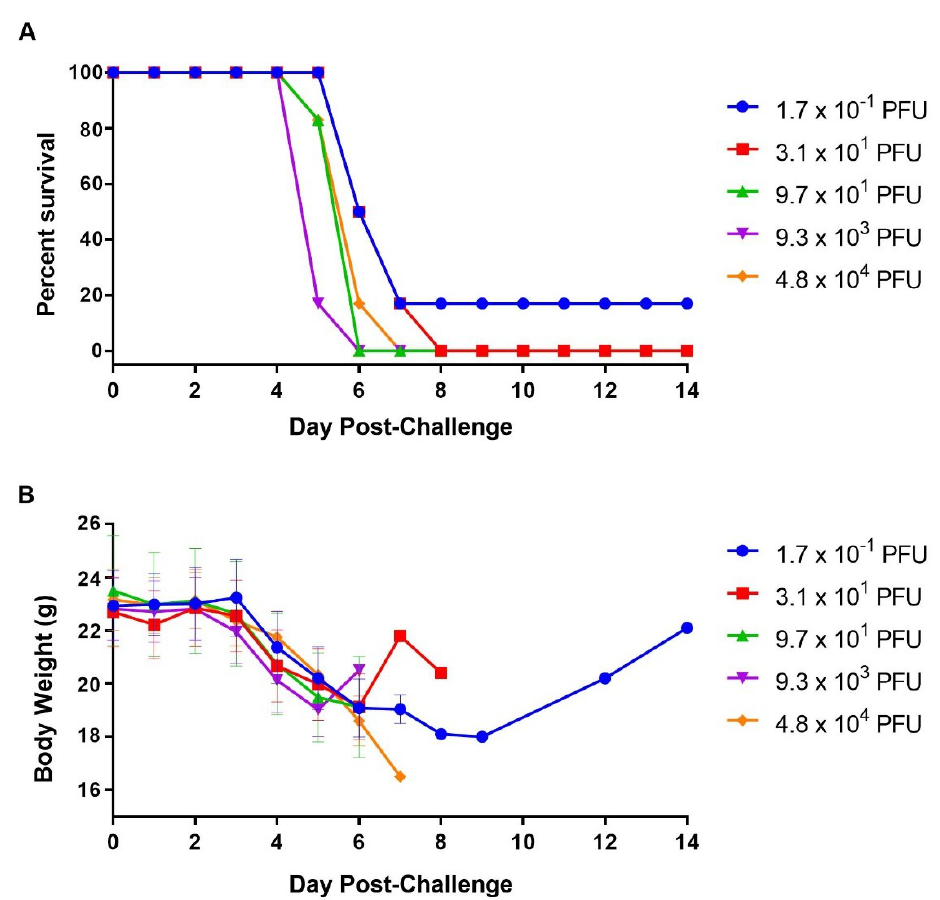
Figure 2. Dilutional Virulence of SUDV in STAT-1 KO mice. Mice (N = 5) were challenged with various doses of SUDV and observed for 14 days for survival ( A ), and body weight loss ( B ). Symbols represent group mean body weights ( B ); bars indicate standard error.